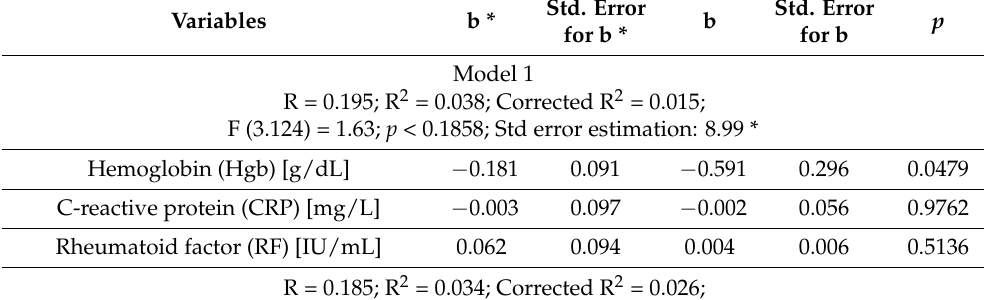
Table 5. Multiple regression results for the FACIT-F variable and independent variables. Std. Variables b *